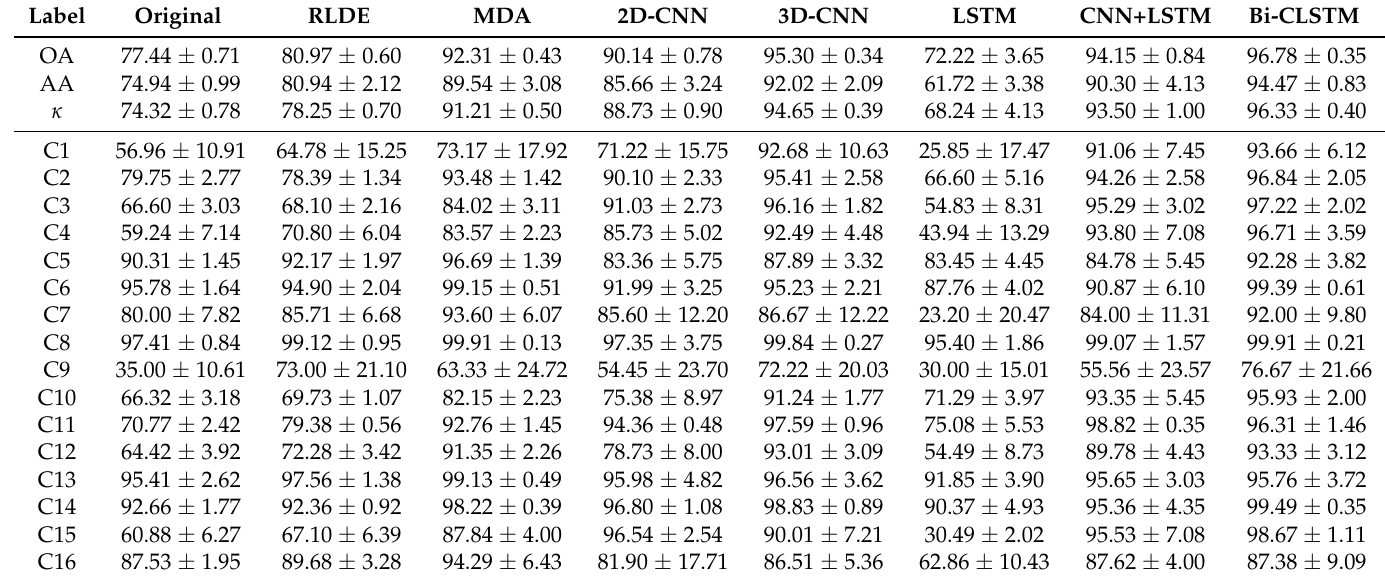
Table 9. OA, AA, per-class accuracy (%), κ and standard deviations after five runs performed by eight methods on the Indian Pines dataset using 10% pixels from each class as the training set.